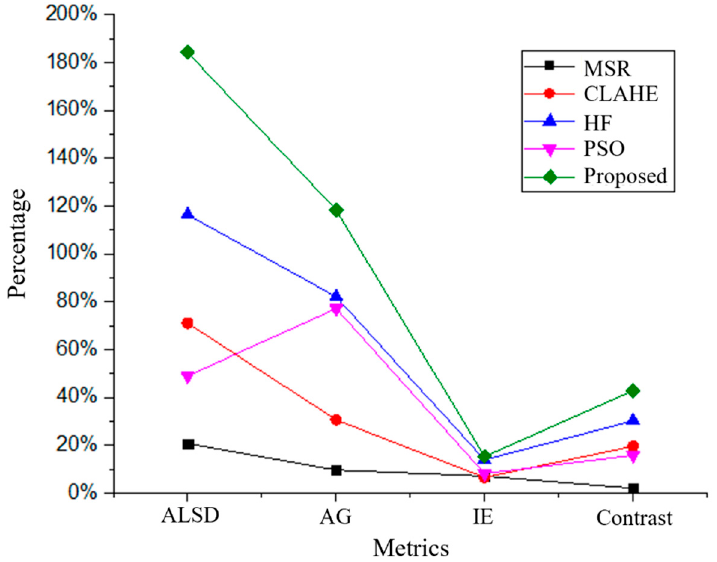
Figure 11. Percentage enhancement of corridor image.